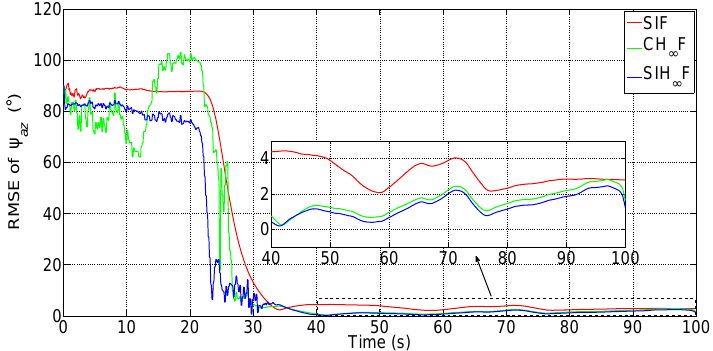
Figure 7. RMSE of ψ az (the subfigure is the magnification of the estimation result during 40 s–100